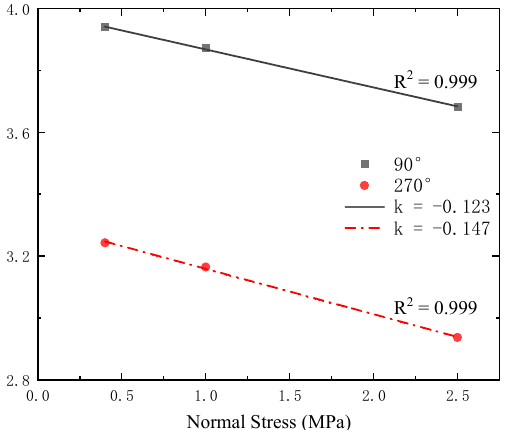
Figure 14. Curves of parameter c vs. normal stress along the 90° and 270° analyzed directions.